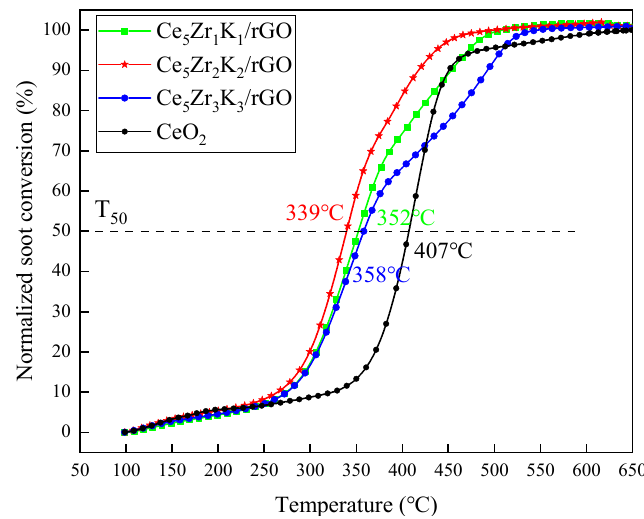
Figure 10. Normalized soot conversion versus temperature of CeZrK/rGO catalysts under tight contact mode in simulated air (21% O 2 + 79% N 2 ).